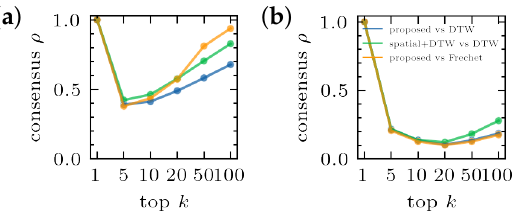
Figure 6. Consensus between the proposed method, the reference method, and their variants. ( a ) Strictly similar time series search; ( b ) Search time series with similar trend.